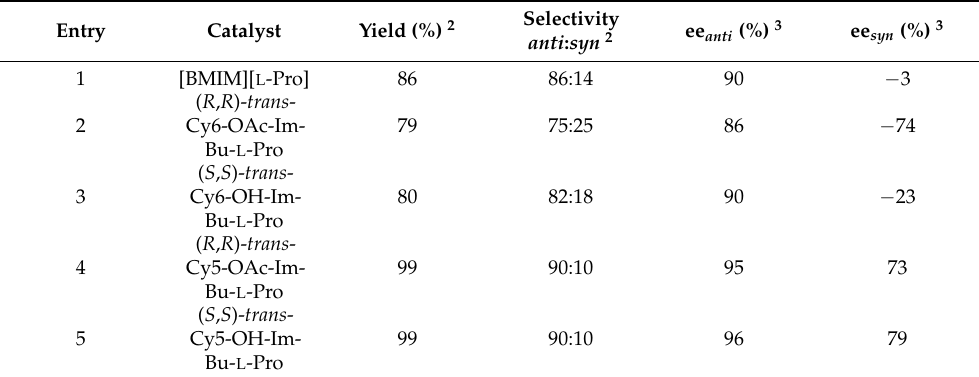
Table 4. Results for the aldol reaction between p -nitrobenzaldehyde and cyclohexanone using different prolinates (40% catalyst loading) at room temperature in the absence of solvent 1